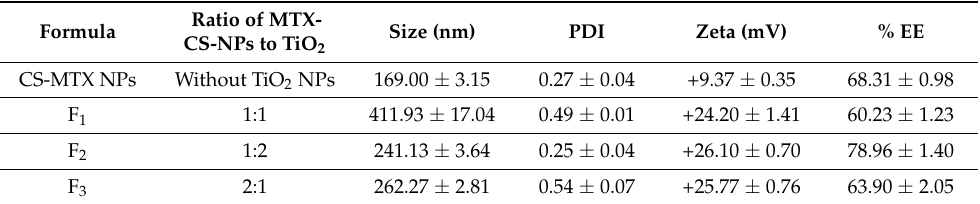
Table 1. Physical characterization of MTX-CS-NPs before coating and MTX-CS-NPs coated with TiO 2 -NPs (1:1, 1:2 and